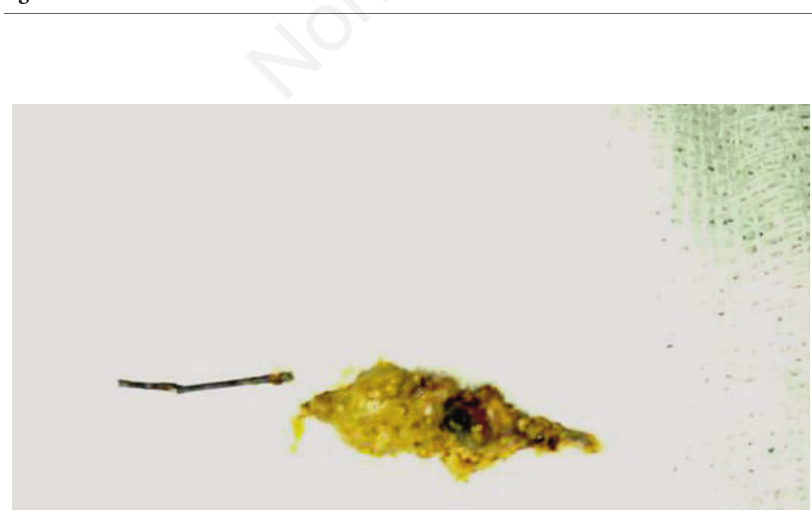
Figure 3. Lateral and postero-anterior skull radiographs show metallic opacity on the right frontal bone.